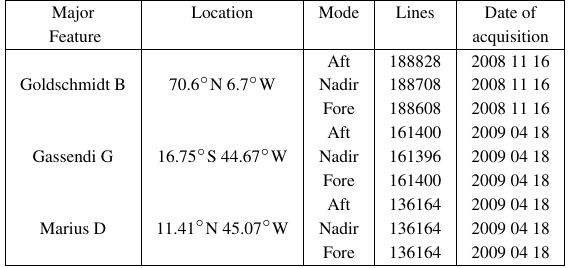
Table 2: LOLA Data set